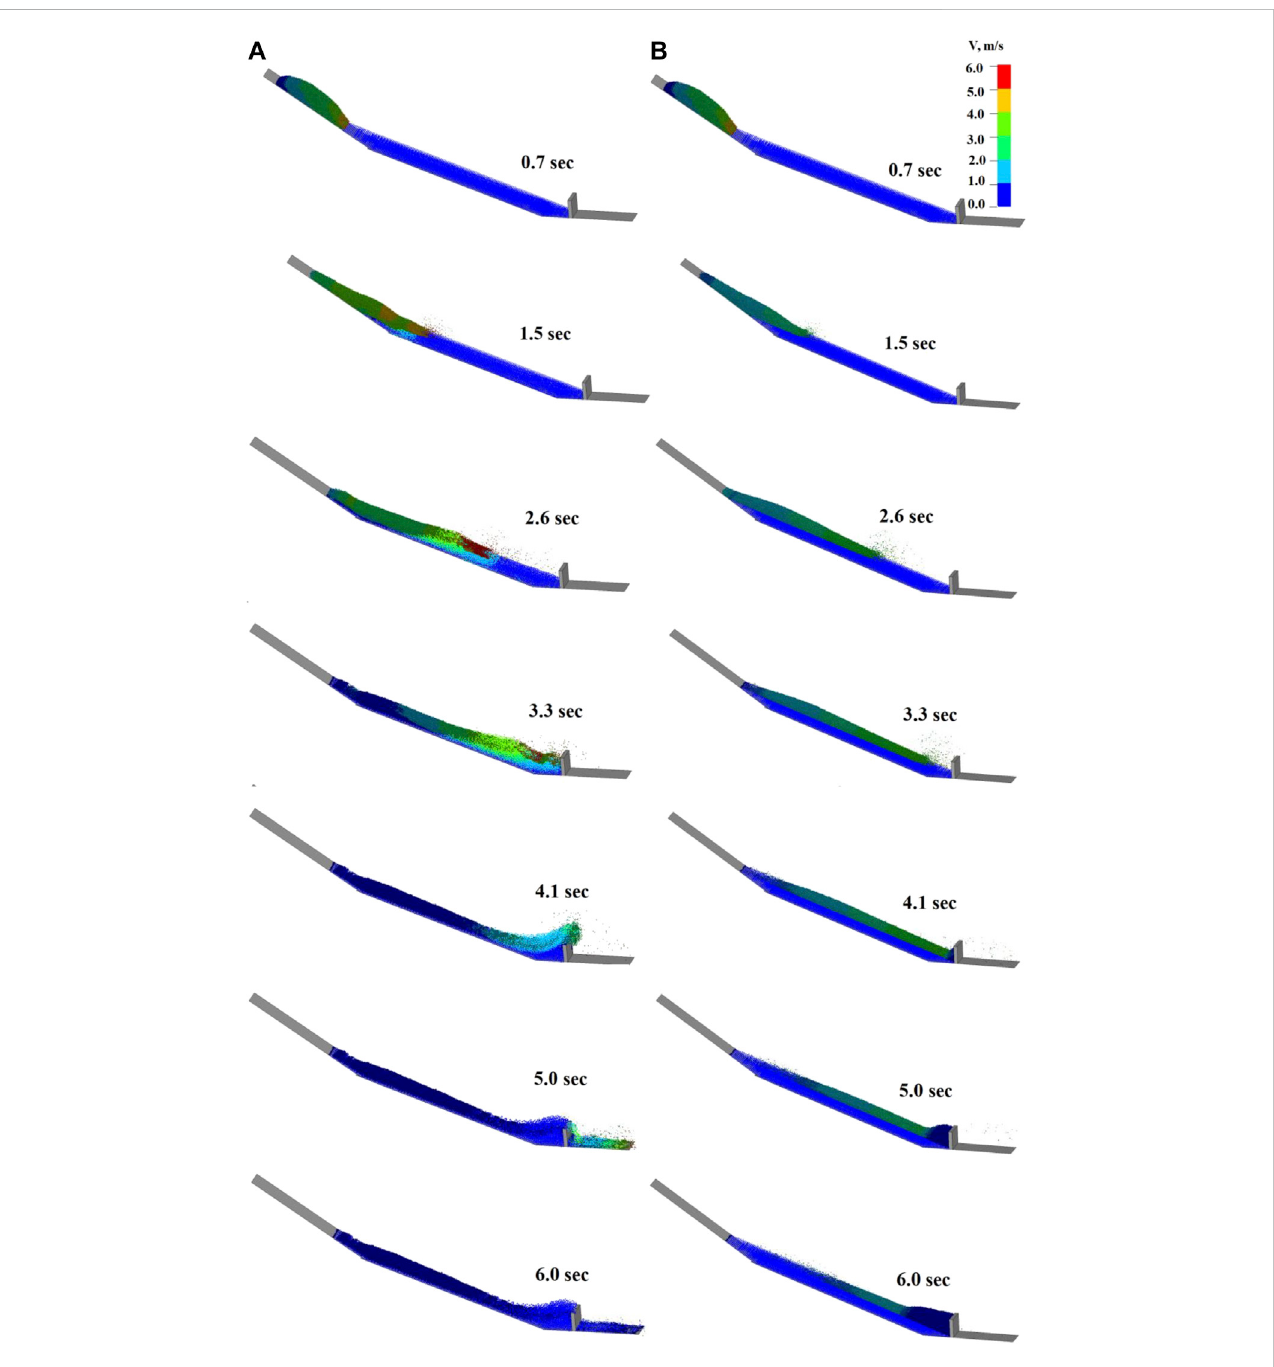
FIGURE 13 Comparison of debris fl ow impact process and velocity vector results with and without erosion-entrainment